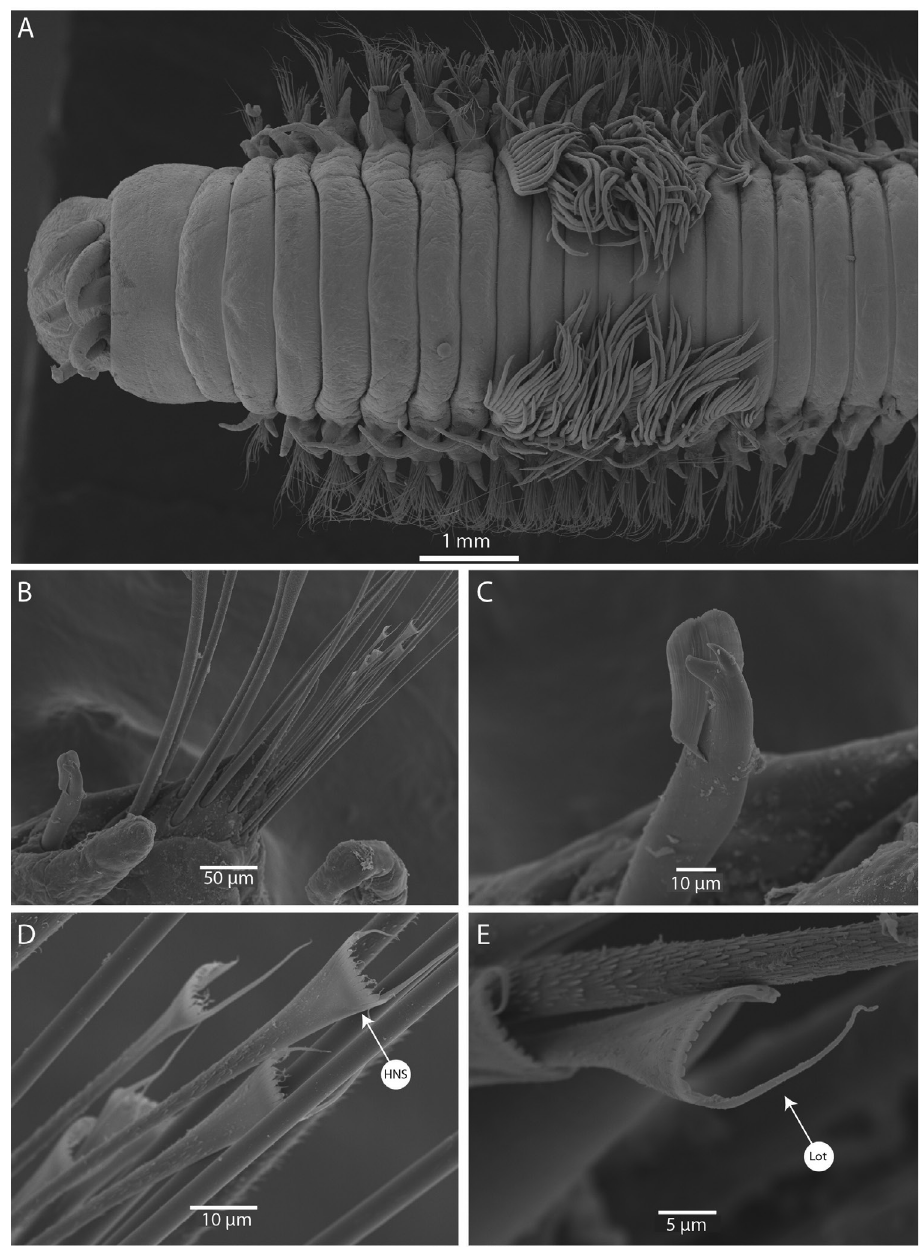
Figure 7. SEM images of Marphysa papuaensis sp. nov. paratypes AM W.53771 ( A ), AM W.53770 ( B–E ) A anterior end, dorsal view B parapodia, chaetiger 79 C subacicular hook, chaetiger 79 D pec- tinate chaetae, chaetiger 79 E pectinate chaetae, chaetiger 41. Abbreviations: HNS, heterodont-narrow- slender; Lot, Long outer